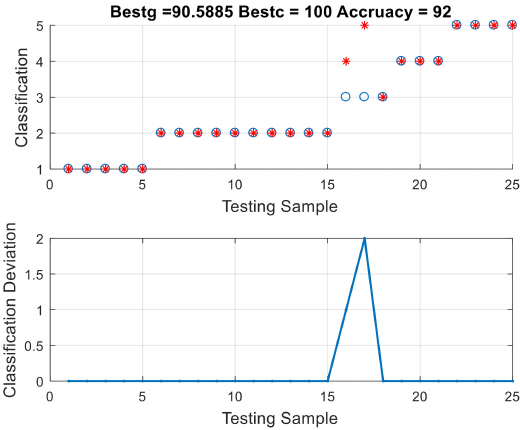
Figure 10. Diagnosis result of